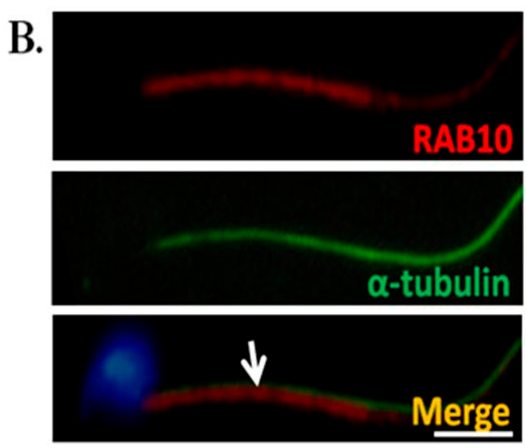
Figure 6. RAB10 is colocalized with α -tubulin at elongating spermatids and mature spermatozoa; Immunofluorescence detection of RAB10 and α -tubulin in elongating spermatids ( A ) and mature spermatozoa ( B ); The arrow indicates the co-staining signals of RAB10 and α -tubulin; Scale bar: 5 μ m.